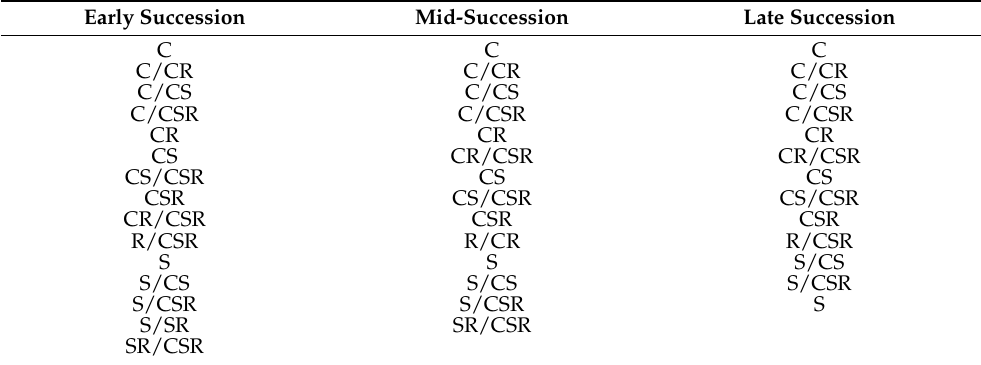
Table 2. The types of community-level ecological strategies identified in different successional